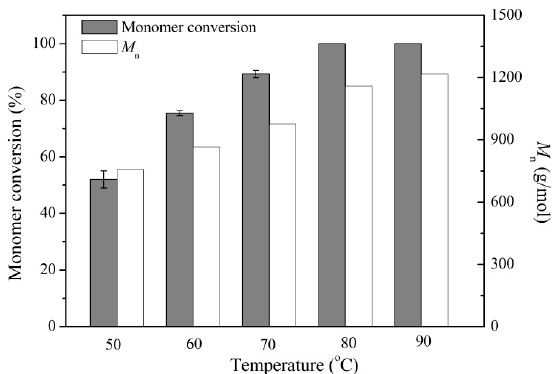
Figure 3. Effect of temperature on monomer conversion and product molecular weight M n . The reactions were carried out using 200 μ L ε -caprolactone and 600 μ L toluene at different temperatures for 72 h.